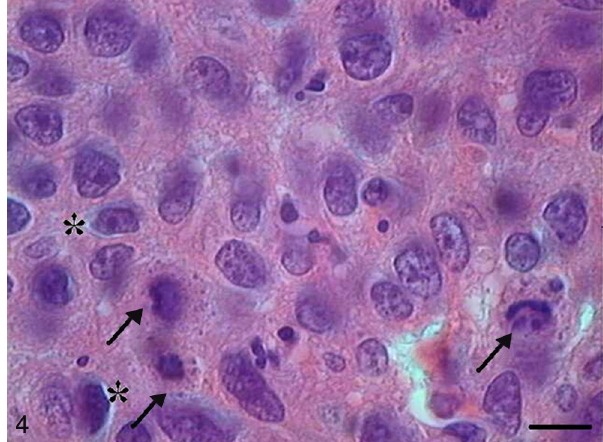
Figure 4 Grade II squamous carcinoma cells. Micrograph of grade II squamous carcinoma cells with presence of apoptotic cells with condensation of cytoplasm (arrows) and anoikis (*) (HE, bar = 10 (cid:2) m).